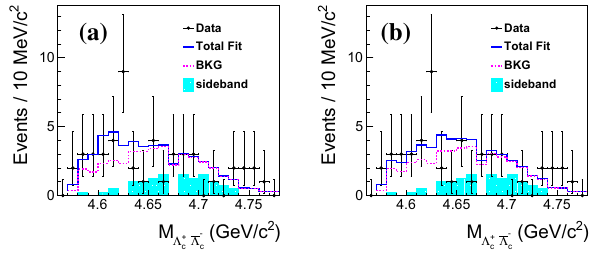
Fig. 5 The (cid:4) + c ¯ (cid:4) − c invariant mass spectra in data with a Y η and b Y(4660) signals included in the fits. The solid blue lines are the best fits and the dotted red lines represent the backgrounds. The shaded cyan histograms are from the normalized (cid:4) + c and ¯ (cid:4) − c mass